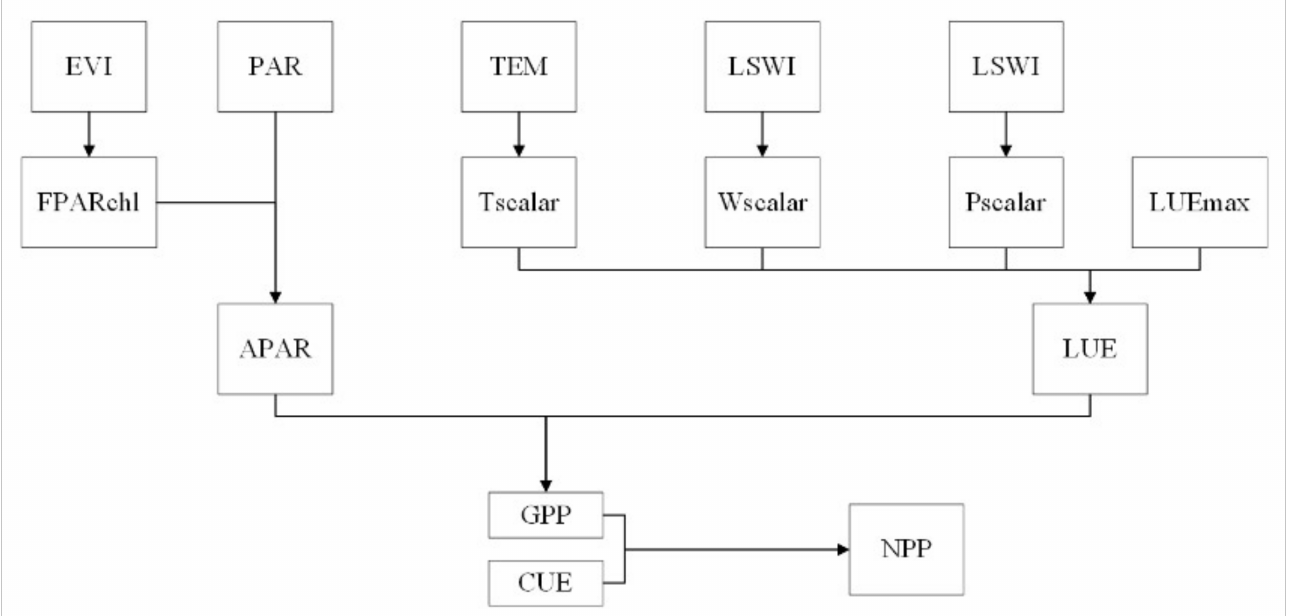
Figure 2. The flowchart of